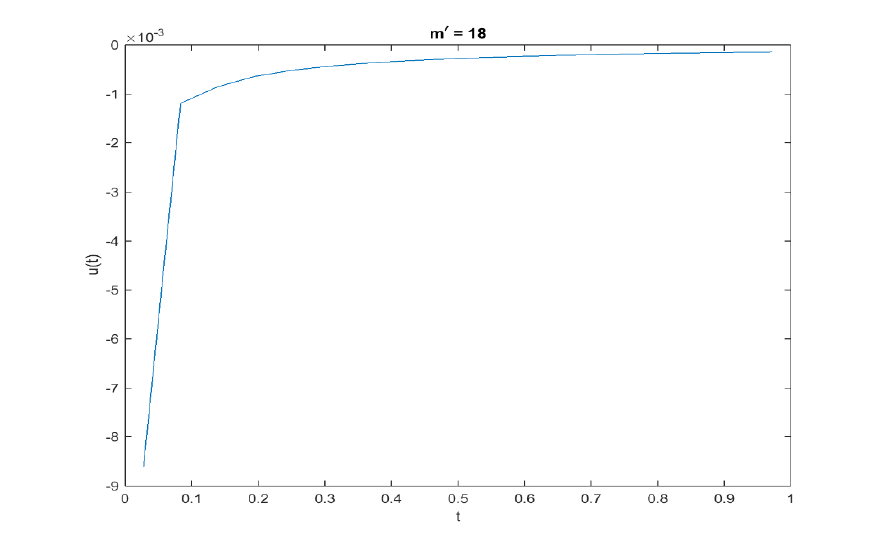
Figure 3. Error plot for Example 3 with .18= '